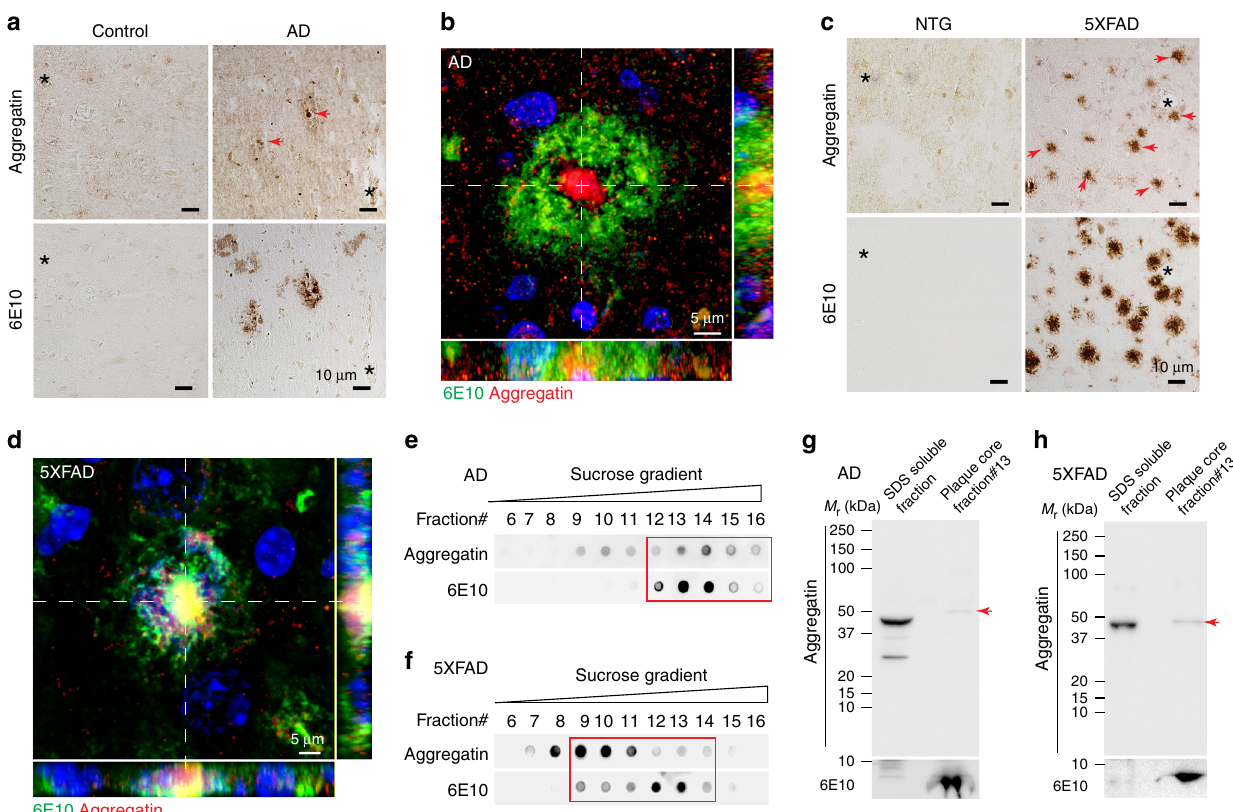
Fig. 2 Aggregatin accumulates within the center of amyloid deposits. a Representative images of immunohistochemistry of Aggregatin (arrowheads) and amyloid plaques (stained by the 6E10 antibody) in adjacent sections (denoted by asterisks) of cortices of sporadic AD patients. b Representative fl uorescent images of Aggregatin (Red), amyloid plaques (Green, stained by the 6E10 antibody) and DAPI nuclei staining (Blue) in cortices of sporadic AD. c Representative images of immunohistochemistry of Aggregatin (arrowheads) and amyloid plaques (stained by the 6E10 antibody) in adjacent sections (denoted by asterisks) of brains of 6-month-old 5XFAD mice. d Representative images of Aggregatin (Red), amyloid plaques (Green, stained by the 6E10 antibody) and DAPI nuclei staining (Blue) in brains of 6-month-old 5XFAD mice. e , f Representative dot blots of Aggregatin and A β (6E10) in serial fractions of amyloid plaques separated by differential centrifugation in sucrose gradient from sporadic AD patients ( e ) or 6-month-old 5XFAD mice ( f ). g , h Representative immunoblots of Aggregatin and A β (6E10) in the SDS-resistant insoluble core-enriched fraction from sporadic AD patients ( g ) or 6-month- old 5XFAD mice ( h ). Arrow heads point Aggregatin. Due to the presence of urea used for plaque core protein extraction, plaque core fractions show slight shifts compared to SDS soluble fraction. All experiments were independently performed at least three times. Source data are provided as a Source Data fi le (Source Data for Statistics and